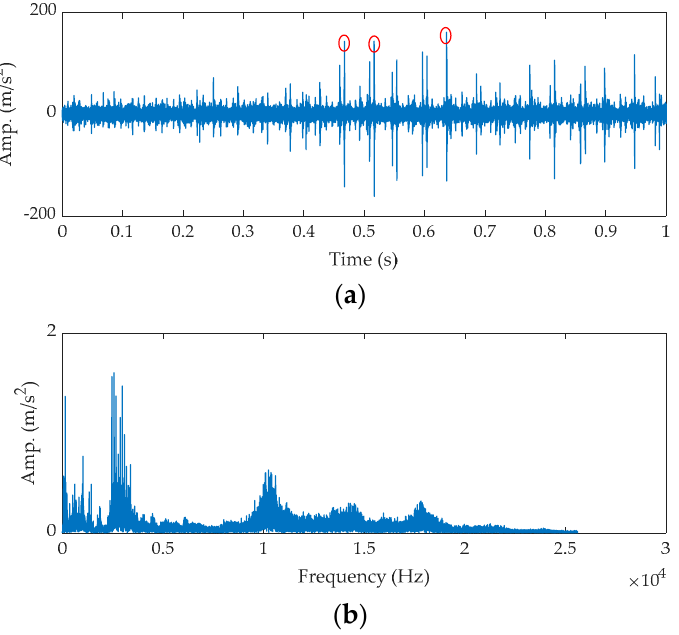
Figure 7. The raw signal for the outer fault bearing: ( a ) time waveform and ( b ) FFT spectrum. The center frequency is first evaluated by the CV index, and the result is shown in Figure 8. The center frequency is 2750 Hz. Then, the MMA is applied to find the ORFB. In this case, the range for searching center frequency is set as [2337, 3162] Hz, and the range for searching bandwidth is set as [124, 628] Hz. From the MMA, the center frequency of ORFB is 2806 Hz and the corresponding bandwidth is 628